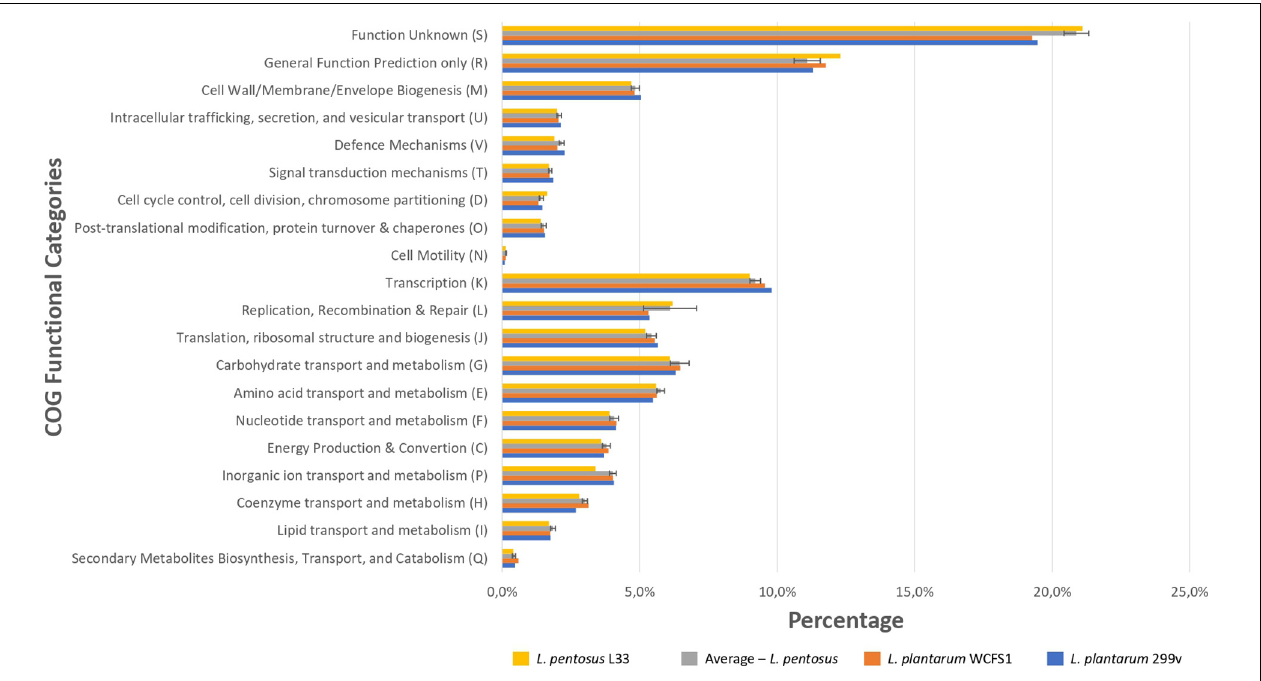
FIGURE 5 | Comparison of the percentage of genes assigned to the COG functional categories of L. pentosus L33 (Yellow bars), L. plantarum WCFS1 (Orange bars), L. plantarum 299v (Blue bars) and of 26 L. pentosus strains (Gray bars). We calculated the percentage of genes for each COG functional category, for each one of the 26 L. pentosus strains, and depict their average values alongside the standard deviation (Gray bars).